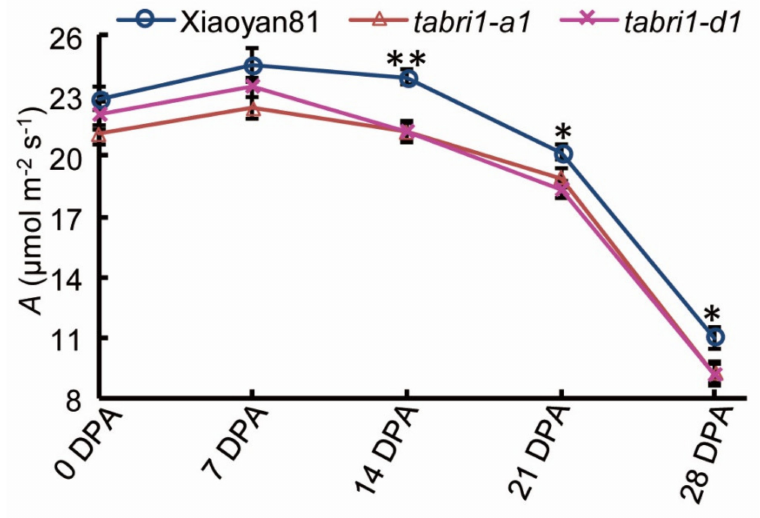
Figure 6. Photosynthesis parameters in WT, TaBRI1-A1 and TaBRI1-D1 mutants during the whole post-anthesis period. CO 2 assimilation rate, A. Each genotype had three biologic replicates at each measurement time, and each biologic replicate comprised eight plants. * and ** indicate significant di ff erences between WT and TaBRI1 mutants at p < 0.05 and p < 0.01,